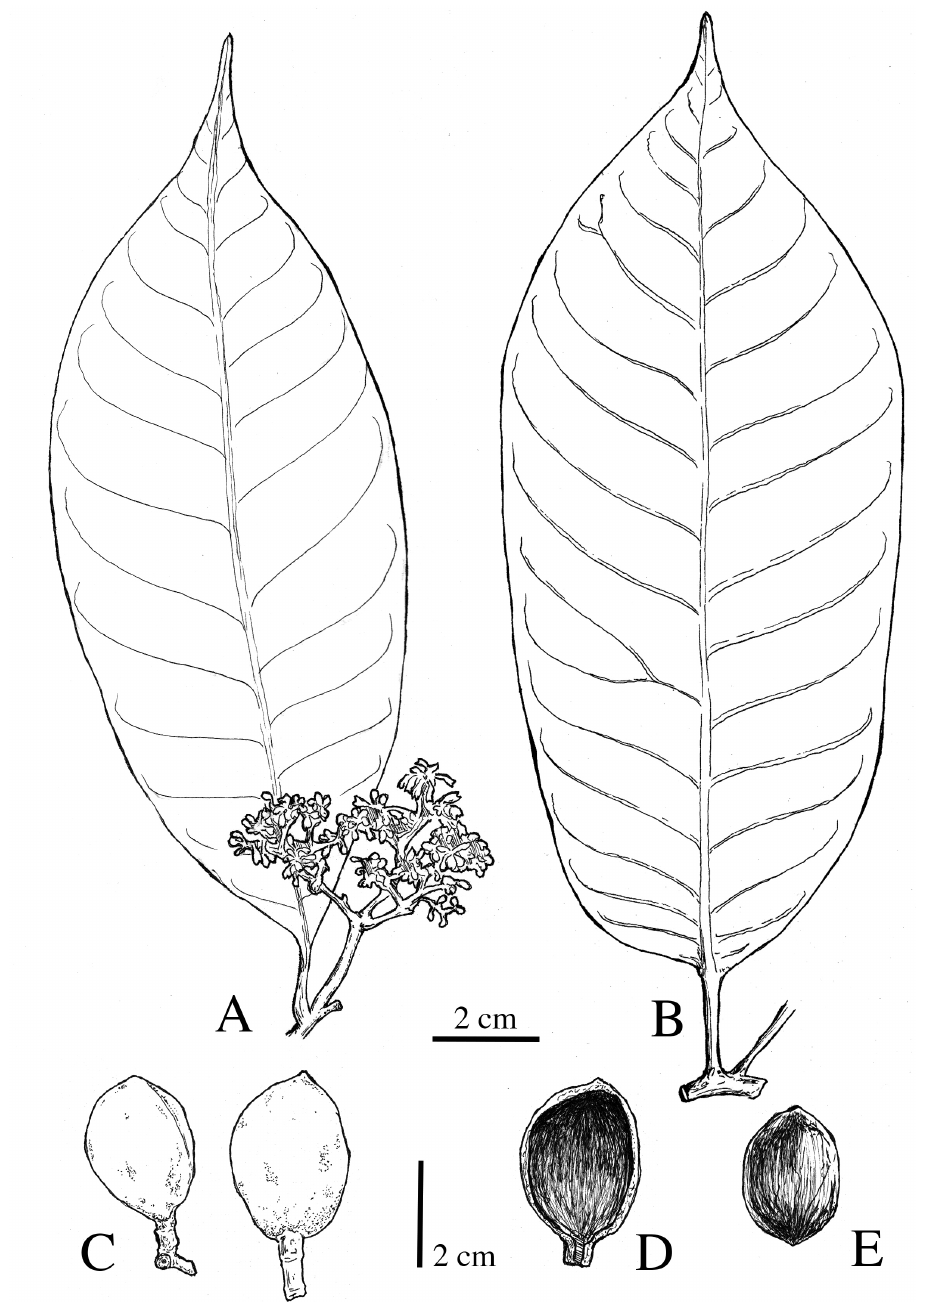
Figure 11. Virola amistadensis A leaf with staminate inflorescences B leaf C fruits D pericarp E seed. Drawn by Pedro Juarez, based on G. McPherson 9717 ( A ) and G. McPherson 9715 ( B–E